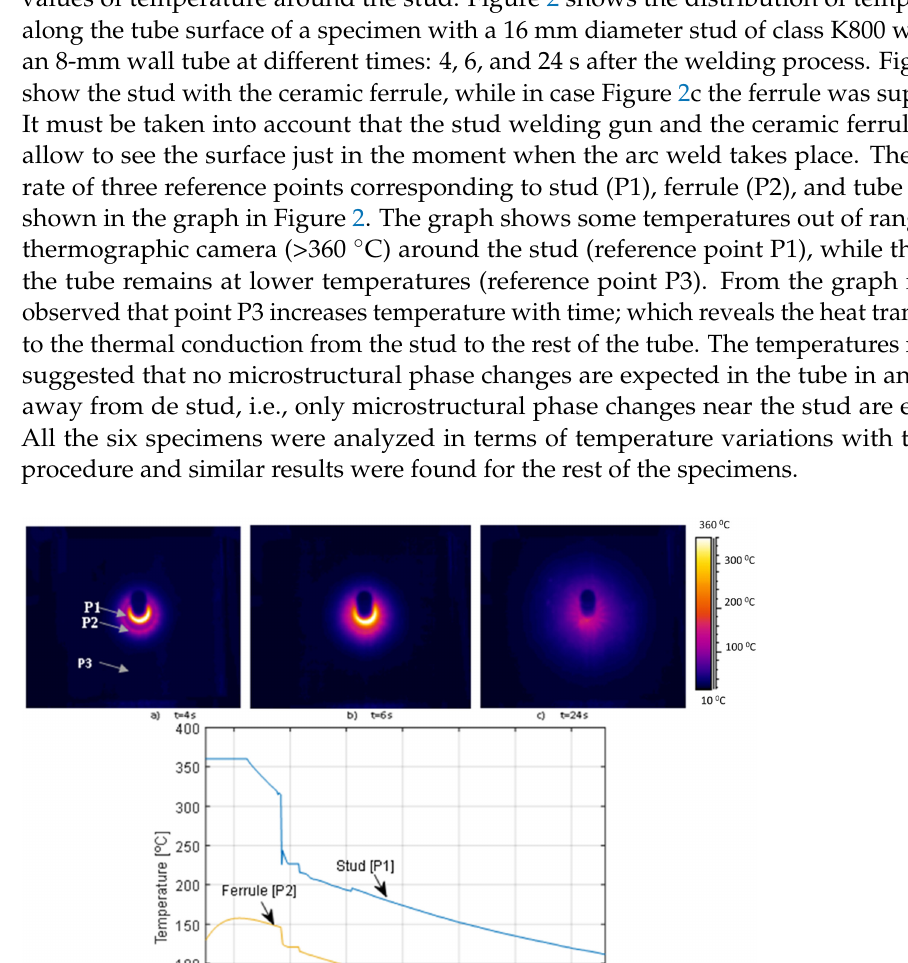
Figure 3. Procedure for preparing the samples through band saw and Wire Electrical Discharge 153 Machining (WEDM). 154